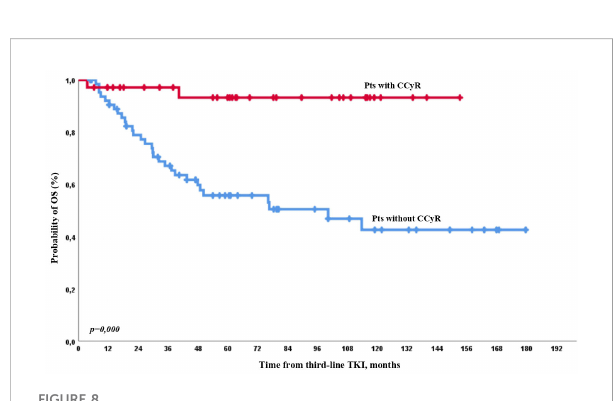
FIGURE 8 OS on third-line therapy according to CCyR achievement on third- line TKI.